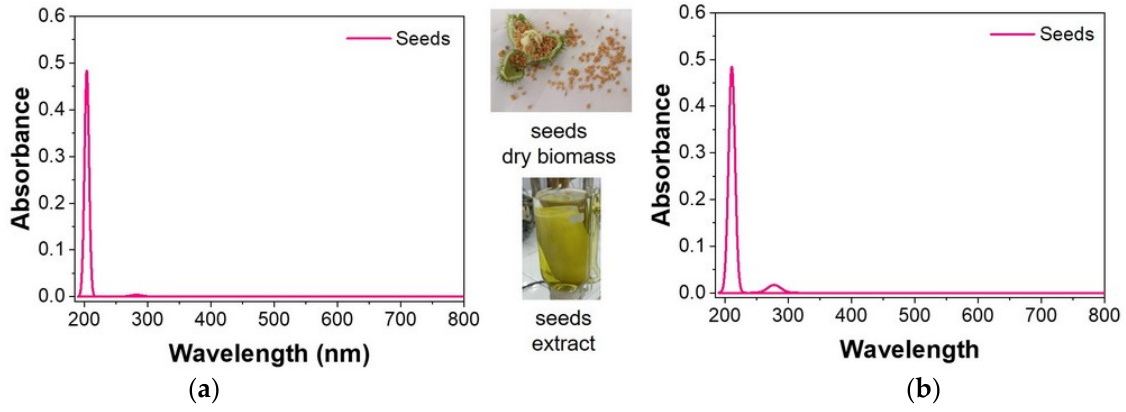
Figure 8. UV–VIS profile absorption spectra after deconvolution for Datura innoxia seeds matrix in ethanol extract ( a ) and 1-butanol extract ( b ).